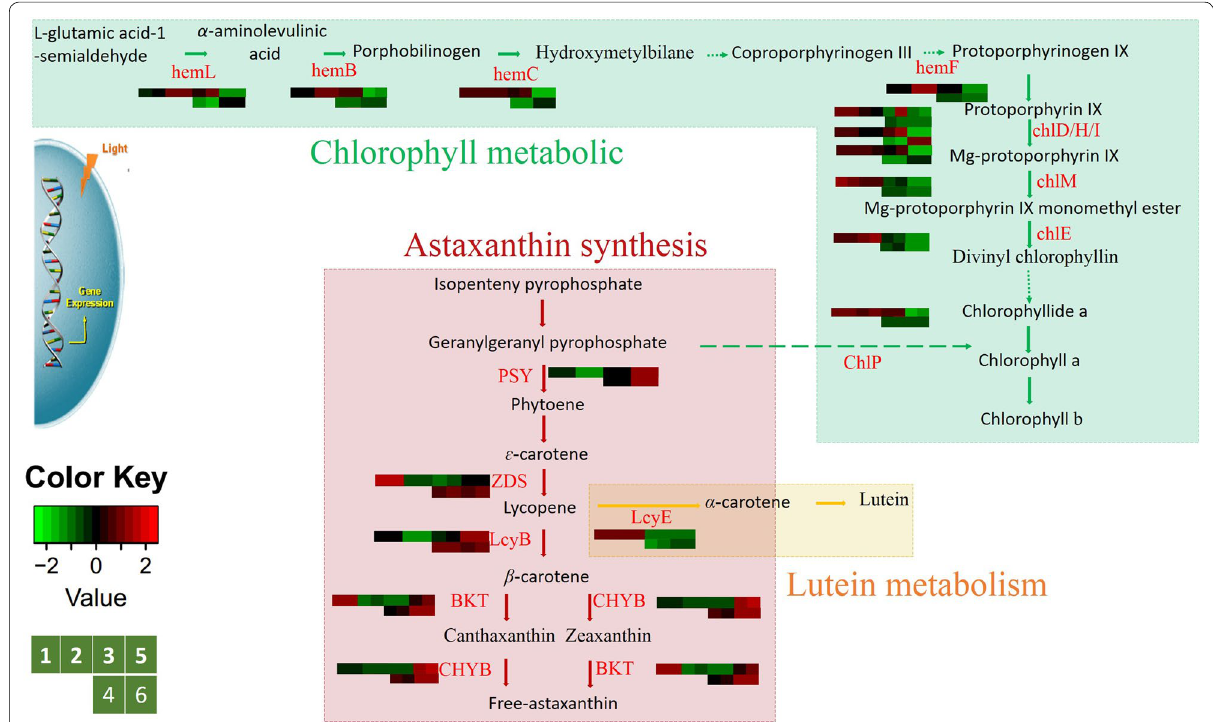
Fig. 4 The metabolic network between chlorophyll metabolism and astaxanthin metabolism in H . pluvialis . Green, red, and yellow background represent chlorophyll metabolism, astaxanthin metabolism, and lutein metabolism, respectively. 1235 (up) and 1246 (down) represent control group and treatment group, respectively ( n 2) =